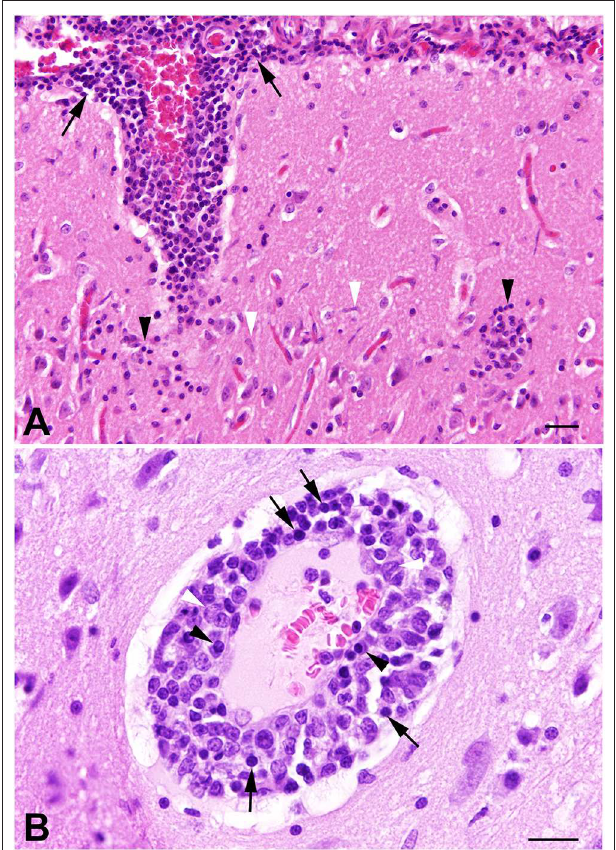
FIGURE 1 | Cat no. 1. (A,B) Histopathology. (A) Cerebral cortex, the leptomeninx (arrows) and neuroparenchyma (black arrowheads) is severely infiltrated with mononuclear inflammatory cells associated with rod-shaped microglial cells (white arrows) in the adjacent neuroparenchyma. HE, bar = 50 µ m. (B) Cerebral cortex showing severe vasculitis with mural and perivascular infiltration of lymphocytes (arrows), macrophages (white arrowheads), and plasma cells (black arrowheads). HE, bar = 60 µ